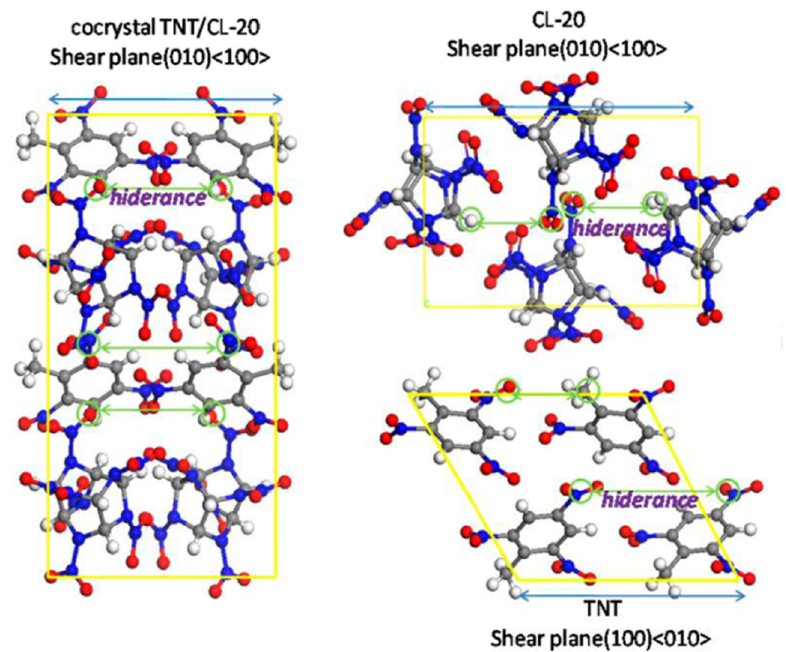
Figure 5: Unit cells of the cocrystal TNT/CL - 20 ( left ) , CL - 20 crystal ( upper right ) , and TNT crystal ( lower right ) including schematic illus - trations of molecule contacts during shear deformation [ 119 ]